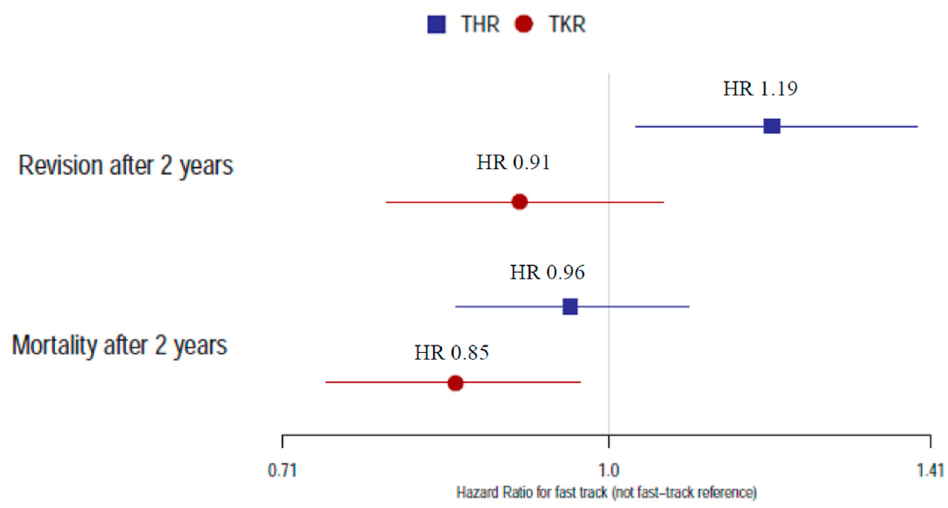
Figure 3. Hazard ratio (95% CI) for revisions and mortality within 2 years in fast-track programs of THR and TKR with non-fast-track as reference. HR: hazard ratio; CI: confidence interval.